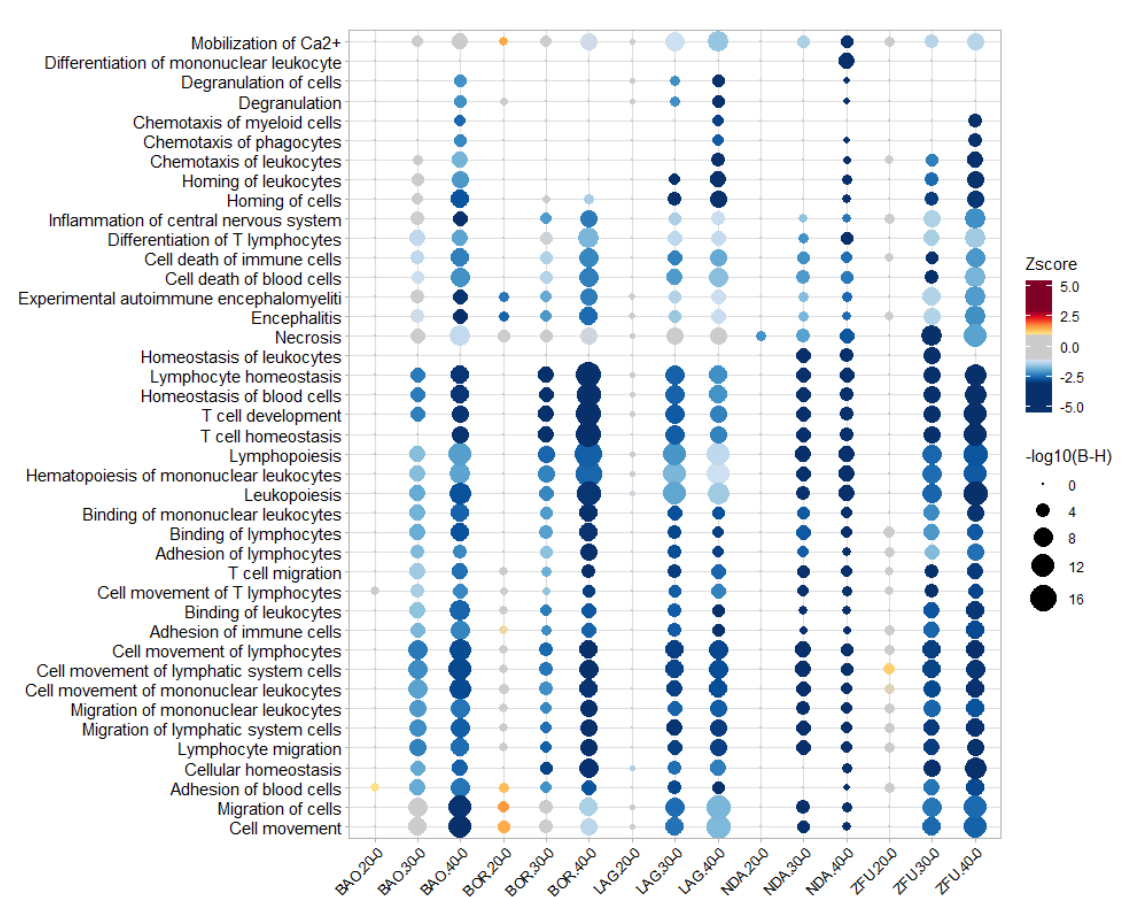
Figure 5 - Plot of 41 significantly enriched diseases and functions inferred as inhibited in function of the within-breed contrasts. The 15 within-breeds contrasts are shown on the abscissa and the significantly enriched diseases and functions on the ordinate. The size of the circles is inversely proportional to the B-H corrected p -value calculated for diseases and functions in the aforementioned contrast. The color gradient of the circle corresponds to the Z-score range, i.e. warm color gradient for positive Z-score>1, cold color gradient for negative Z-score<-1, and gray color gradient for Z-scores ranging between -1 and